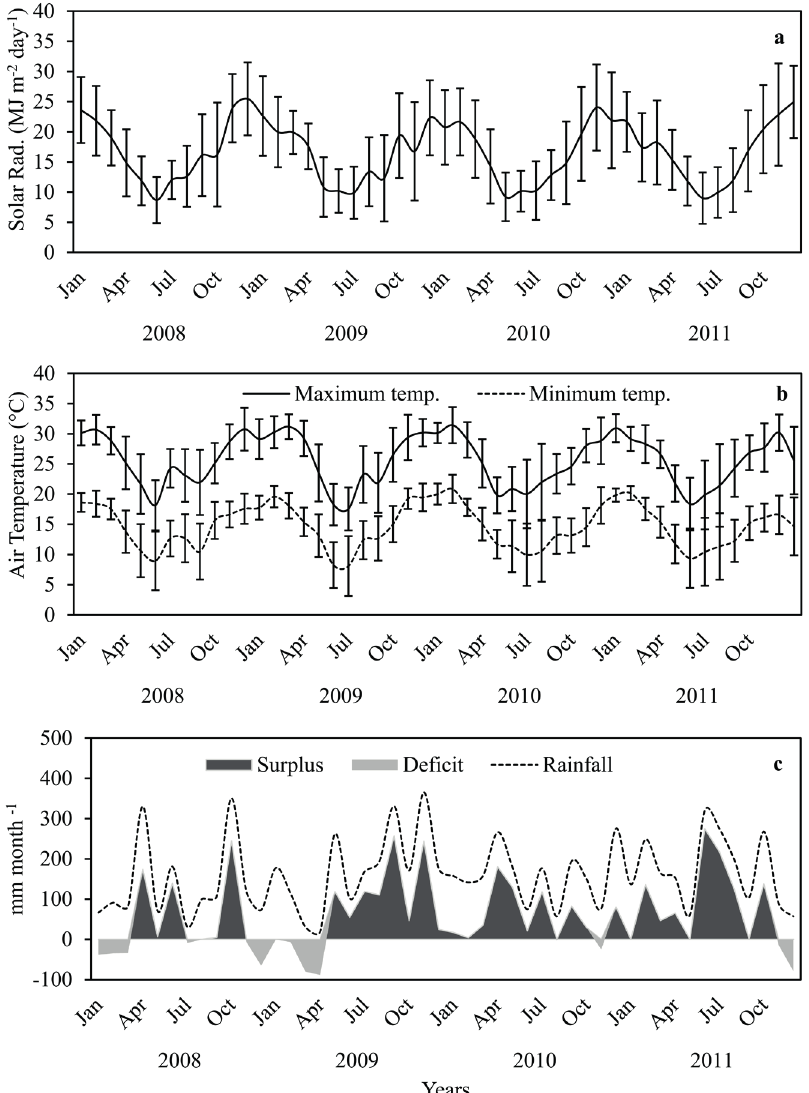
Figure 2 - Average daily global solar radiation ( a ), average monthly maximum and minimum temperature ( b ), rainfall and sequential water balance ( c ) during the years 2008, 2009, 2010 and 2011 in Frederico Westphalen, RS, Brazil. Bars indicate the standard deviation for each